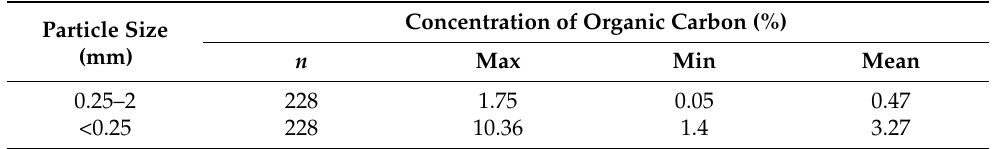
Table 5. Concentrations of organic carbon in 0.25–2 mm and <0.25 mm fraction of stream